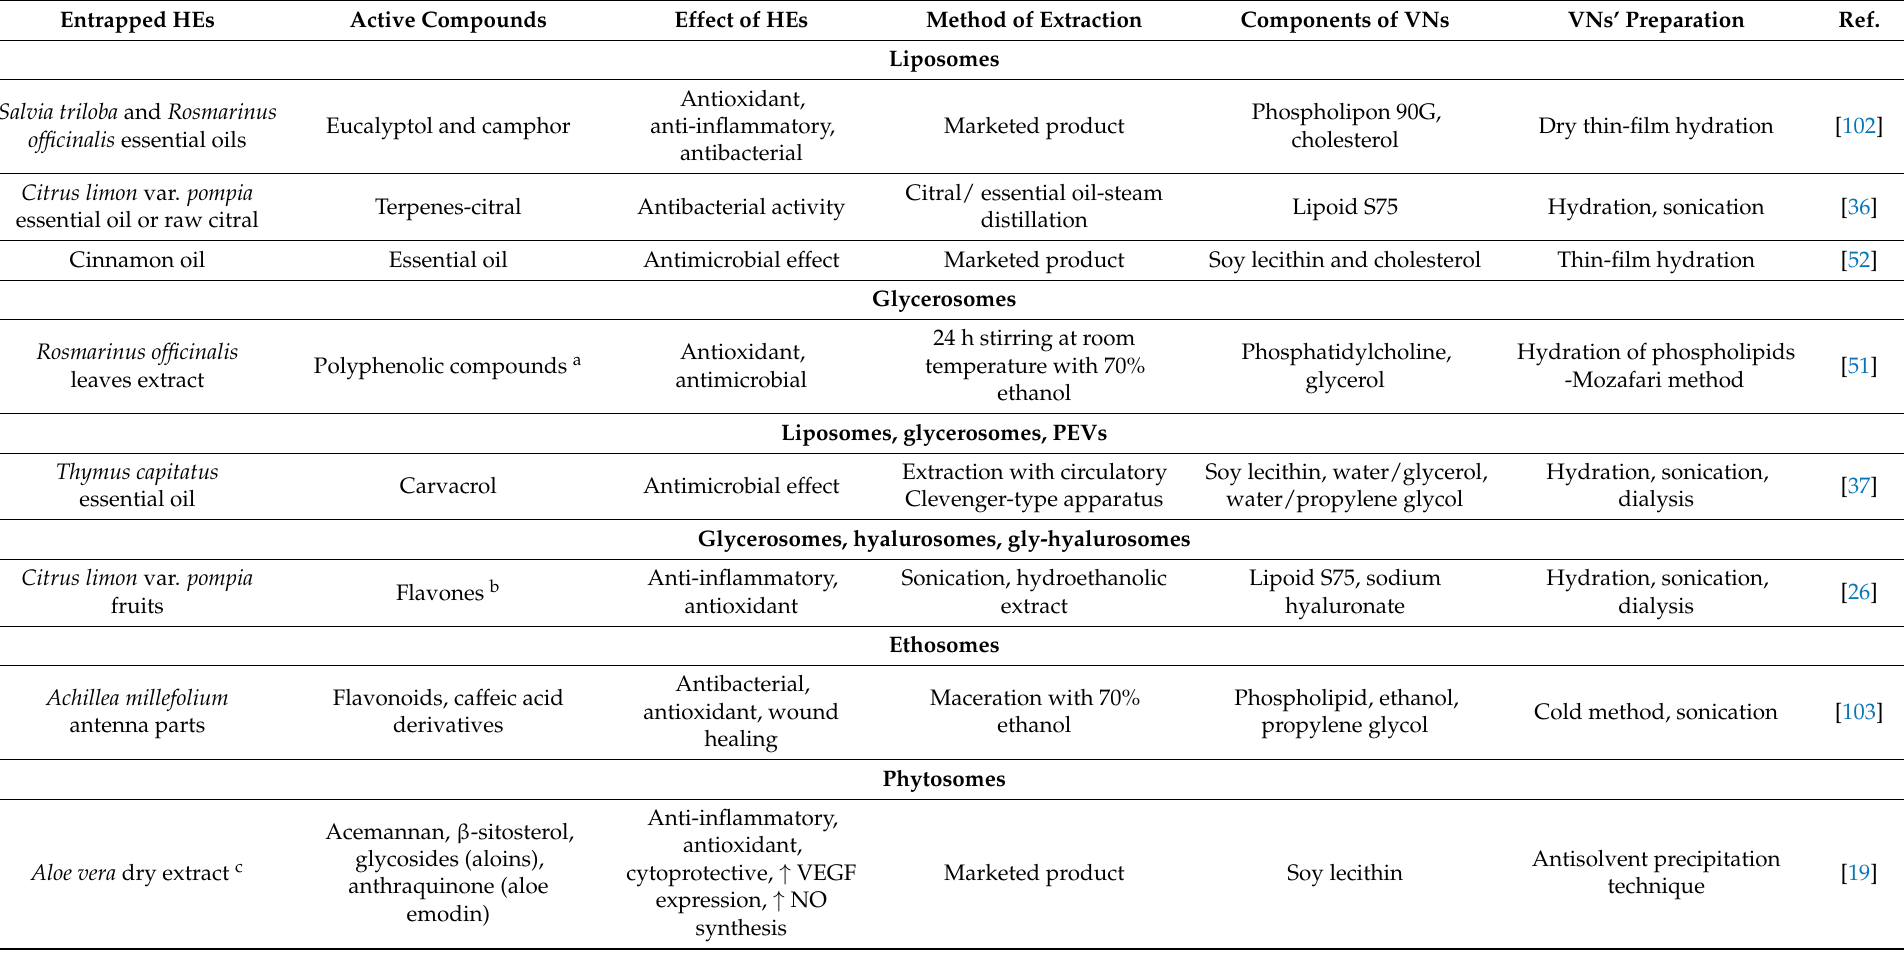
Table 3. Vesicular nanosystems including herbal extracts with potential benefits in the treatment of